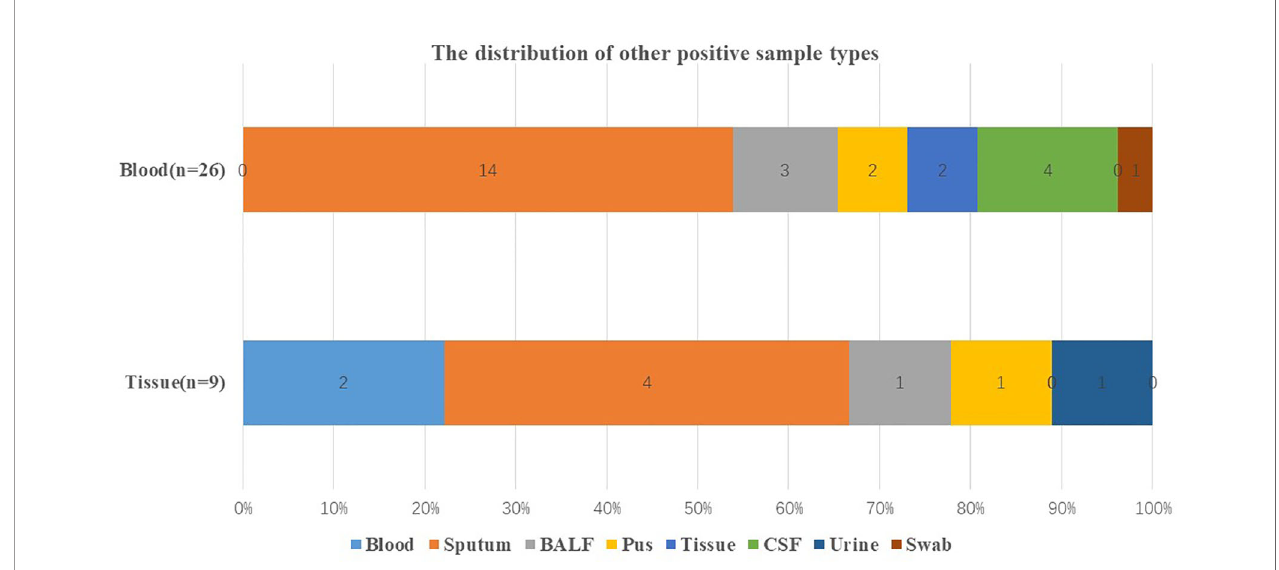
FIGURE 4 | Distribution of other positive sample types. Distribution of other positive sample types when the original sample type was blood and tissue that were with high negative rate. BALF, bronchoalveolar lavage fl uid; CSF, cerebrospinal fl